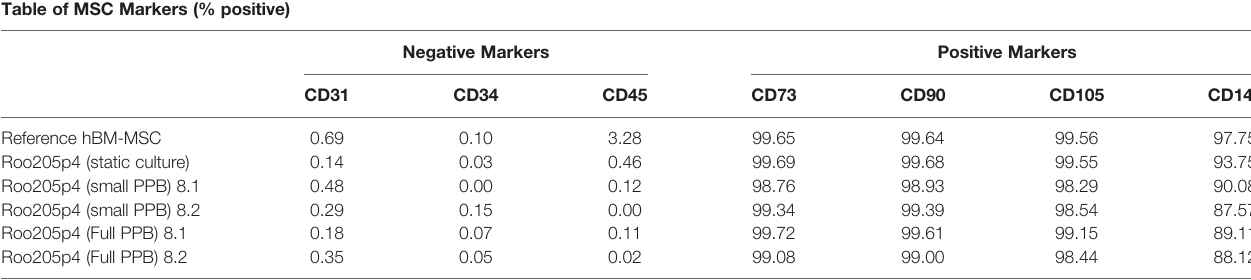
The phenotype of each cell population was determined using a panel of markers used to identify and de fi ne MSCs. Typical expression of the markers is provided by an external bone marrow MSC. The experimental populations consist of the non-sheared control group, Roo205p4 (static culture), the replicate cultures treated with WSS generated using the initial small scale PPB, Roo205p4 (small PPB) 8.1 and 8.2, and the replicate cultures treated with WSS using the large scale PPB, Roo205p4 (large PPB) 8.1 and